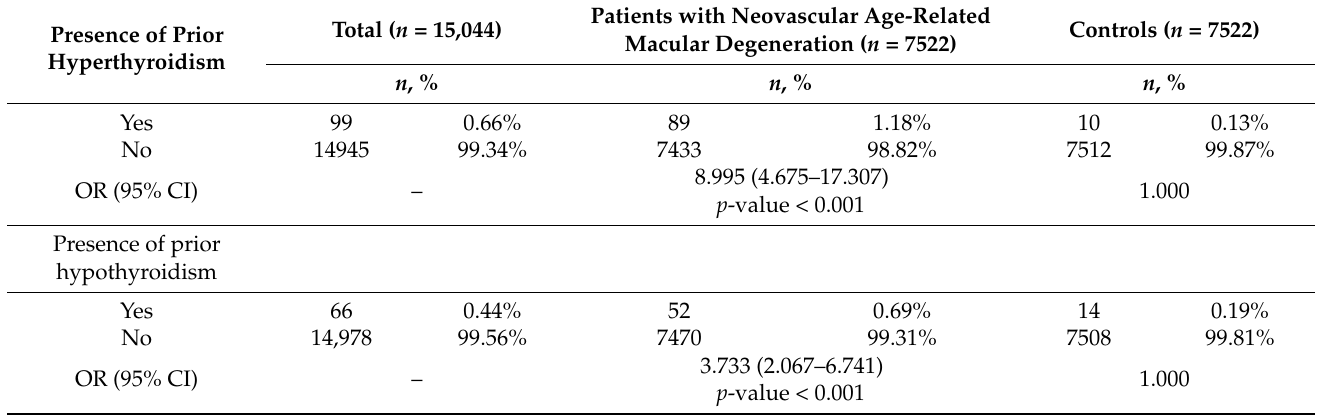
Table 2. Prevalence and unadjusted odds ratios (ORs) and 95% confidence intervals (CIs) for prior hy- perthyroidism or hypothyroidism among patients with neovascular age-related macular degeneration vs.